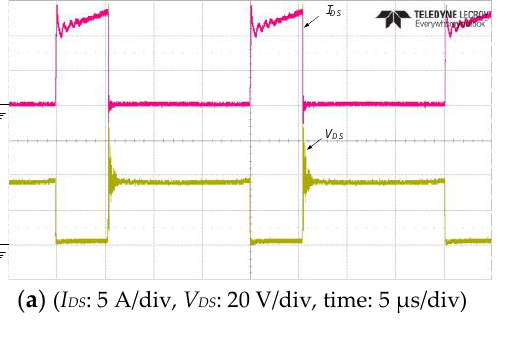
Figure 15. Measured waveforms of switch voltage V DS and current I DS under 100% of the full-load condition when V PV = 36 V: ( a ) switch M 2 and ( b ) switch M 3.